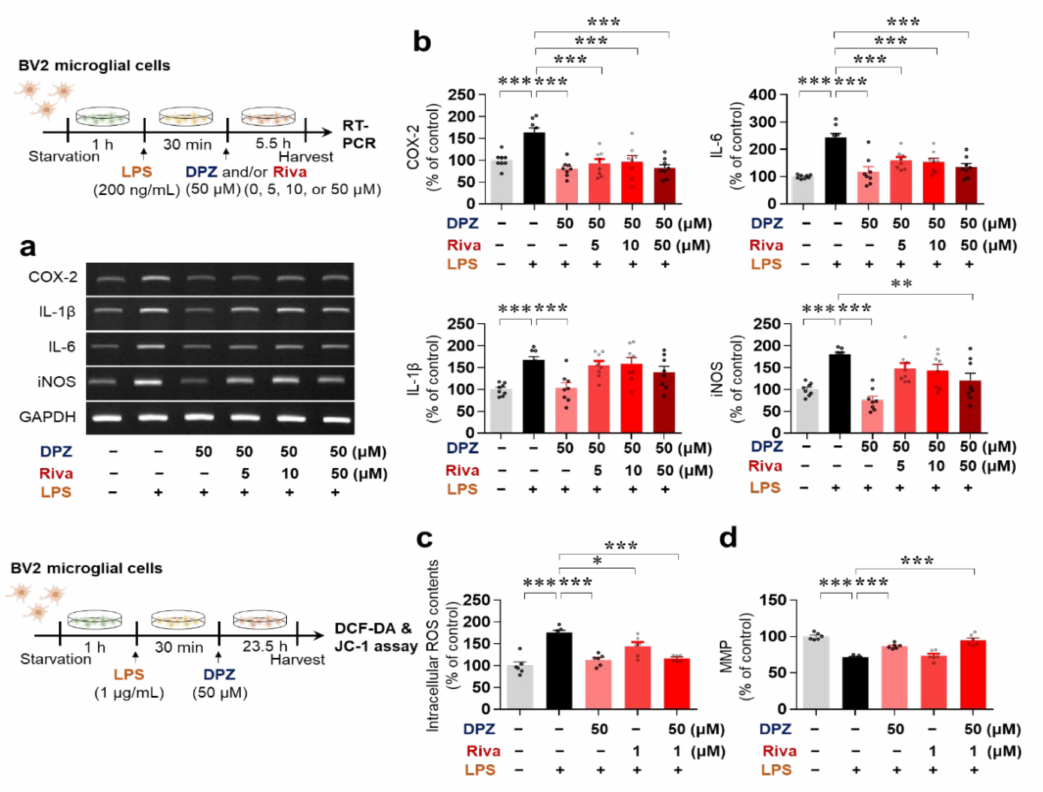
Figure 2. Donepezil affects LPS-stimulated ROS production and mitochondrial function in BV2 microglial cells. ( a , b ) RT-PCR analysis of proinflammatory cytokine levels in BV2 microglial cells pretreated with LPS or PBS and co-treated with 50 µ M donepezil and a range of rivastigmine concentrations as shown ( n = 6/group). ( c , d ) Intracellular ROS content and mitochondrial membrane potential damage, as evaluated by DCF-DA and the JC-1 assay, respectively, in BV2 microglial cells pretreated with LPS or PBS and treated with donepezil and/or rivastigmine as shown ( n = 6/group). * p < 0.05, ** p < 0.01, *** p <